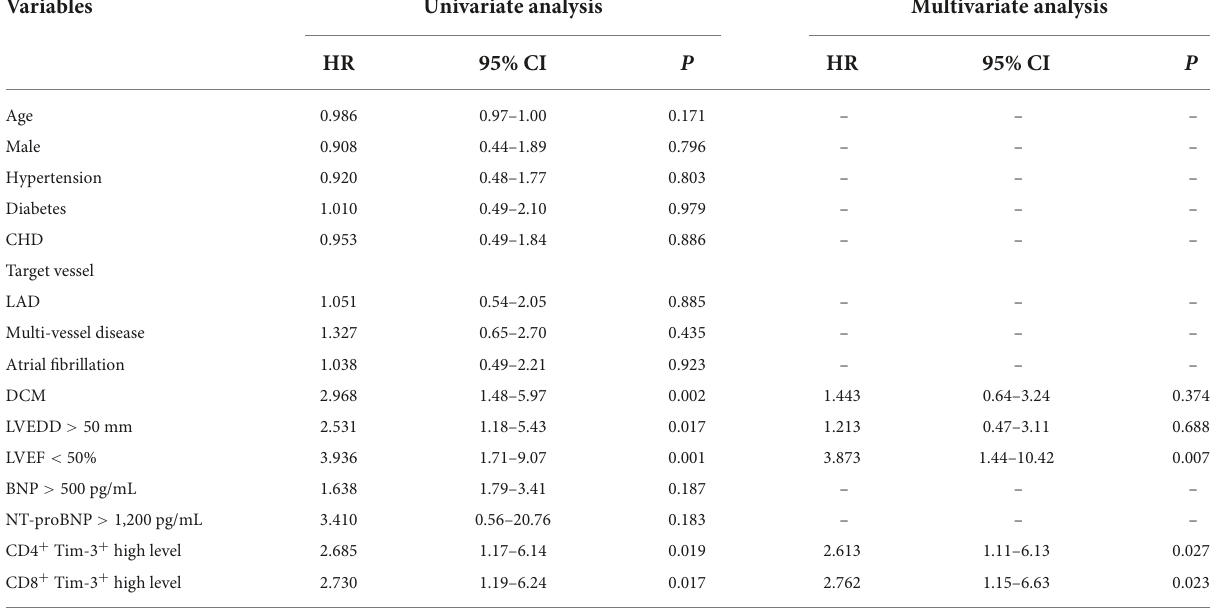
TABLE 5 Univariate and multivariate cox proportional hazard regression analyses for the risk of MACCE within 12 months among patients with